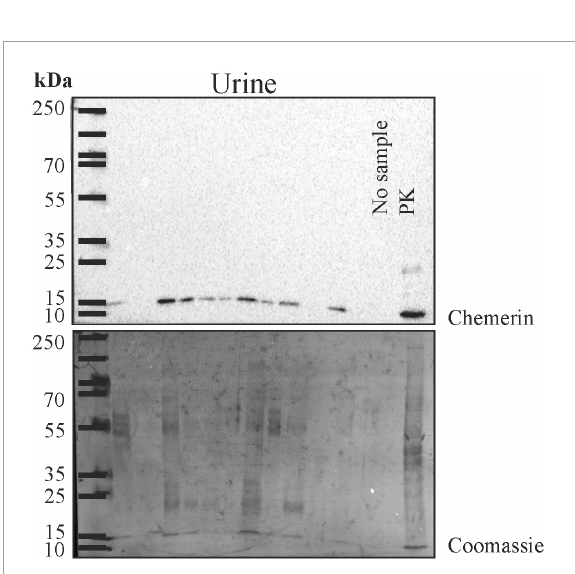
FIGURE2 Immunoblot of urine for analysis of chemerin protein. After the experiment the membrane was stained with Coomassie Brilliant Blue R-250. The molecular weight size marker is shown and the respective molecular weights are given. Human liver lysate was used as positive control